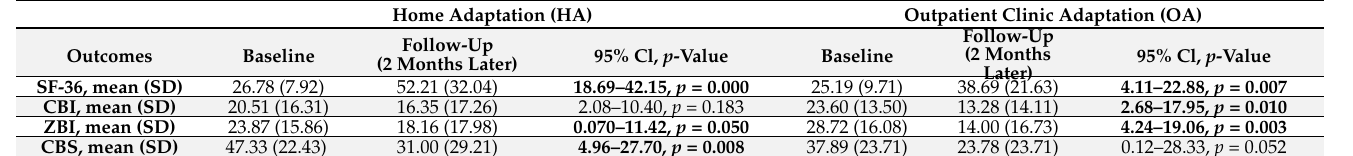
Table 4. Quality of life and caregiver burden results within